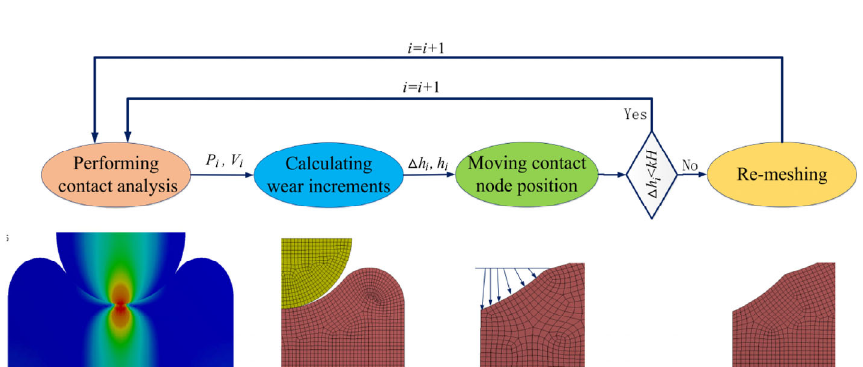
Fig. 4 Basic procedures for simulating the wear evolution